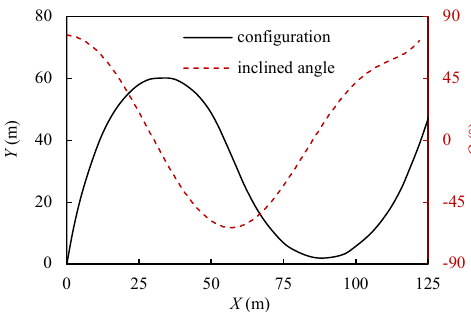
Figure 2. Spatial configuration of a single-peak flexible riser.